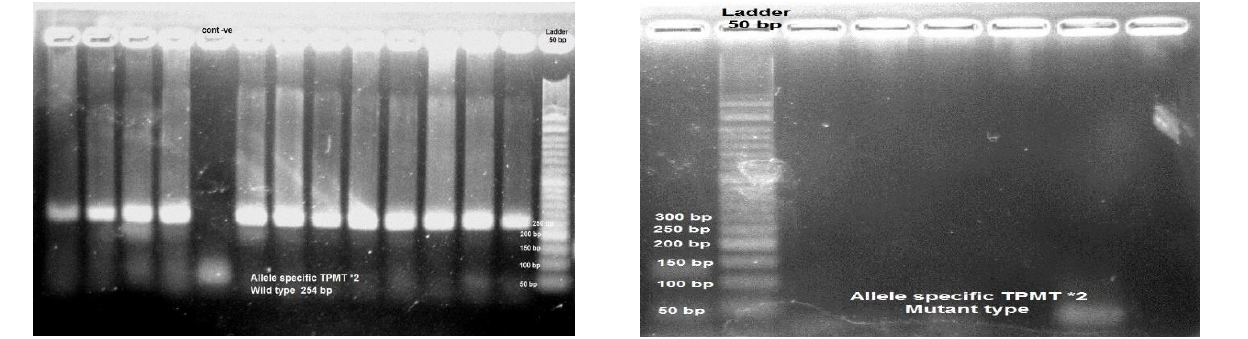
Fig. 1. Allele specific TPMT wild type TPMT*2 Fig. 2. TPMT Allele specific TPMT*2 mutant